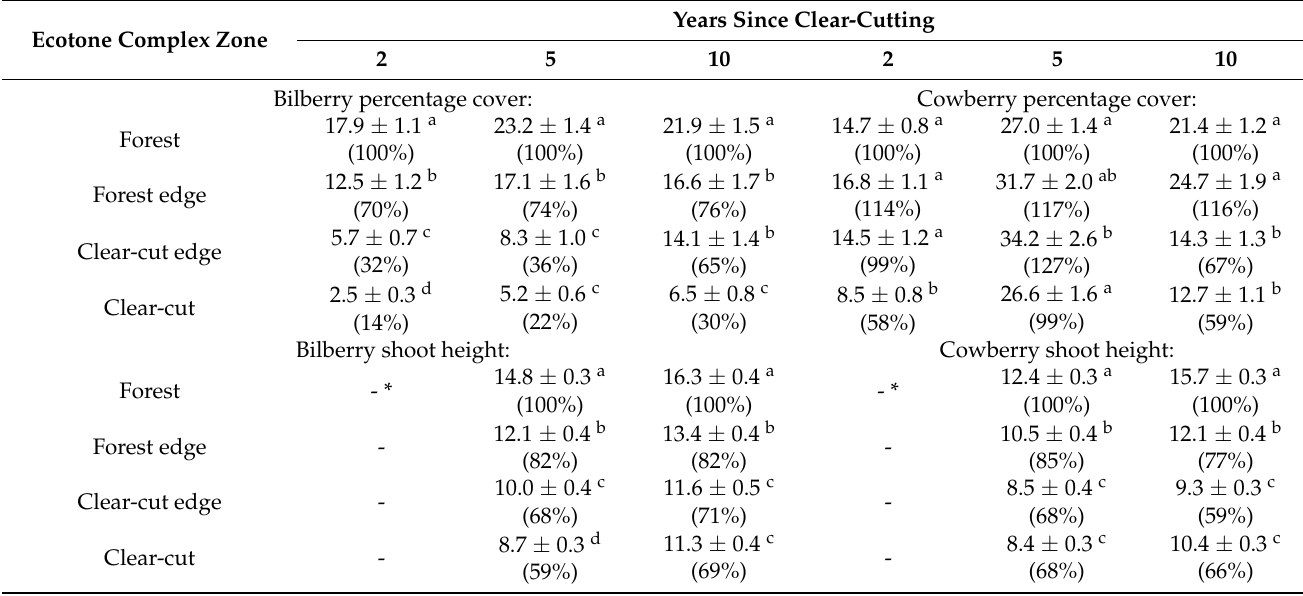
Table 1. Mean percentage covers and shoot heights of forest subshrubs in the ecotone complex 2, 5, and 10 years after